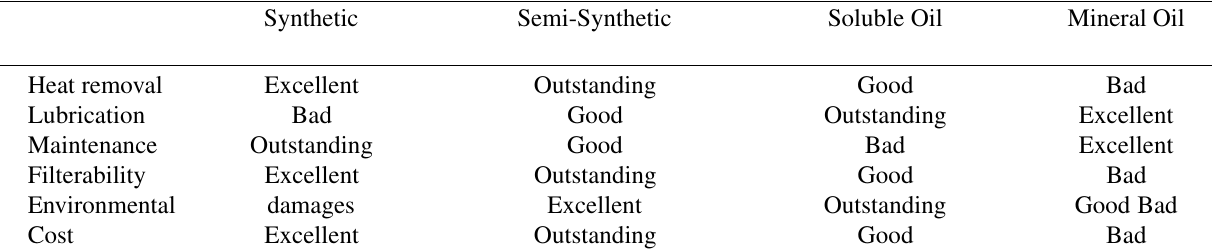
Table 1. Characteristics of the most important fluid types (Webster, 1995).